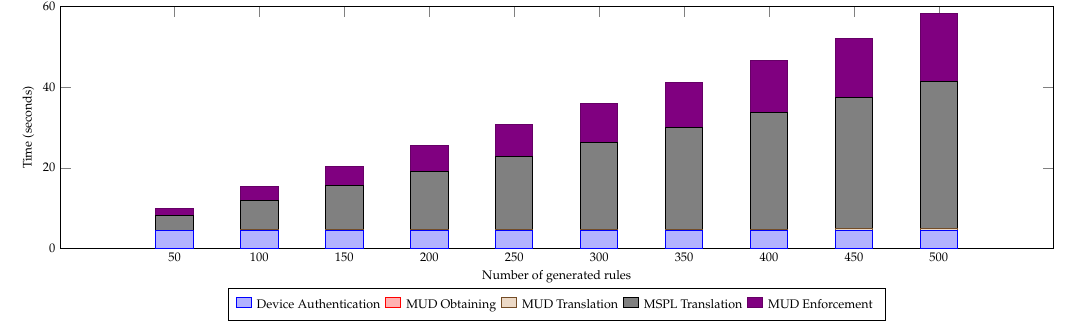
Figure 7. MUD complete process